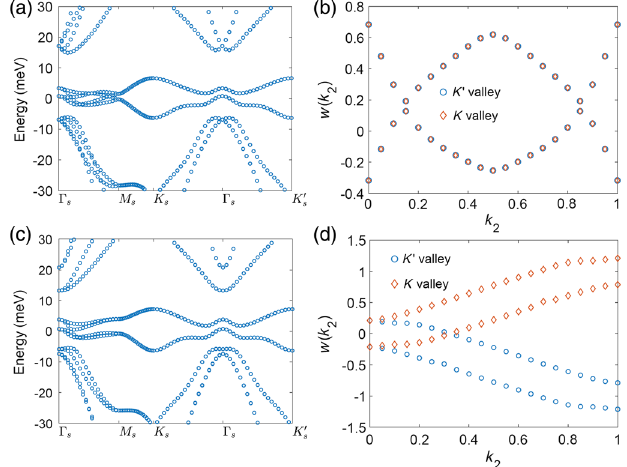
.FIG. 6. The band structures of ( 2 þ 2 ) TMG at θ ≈ 1 . 08 ° (a) with opposite stacking chiralities and (c) with the same stacking chirality. The Wilson loops of ( 2 þ 2 ) TMG at θ ≈ 1 . 08 ° (b) with opposite stacking chiralities and (d) with the same stacking chirality. The blue circles and red diamonds denote the Wilson loops of the K and K 0